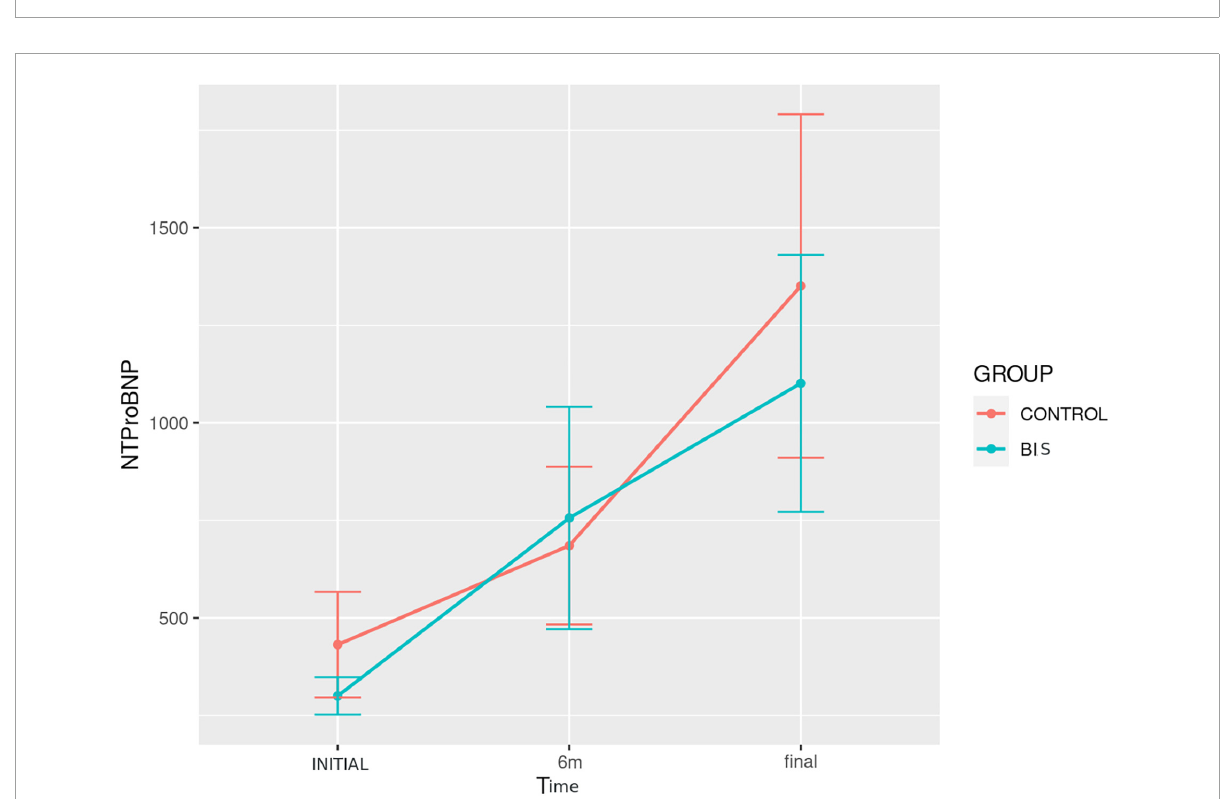
FIGURE5 Evolution of NT-proBNP concentration over time in the study